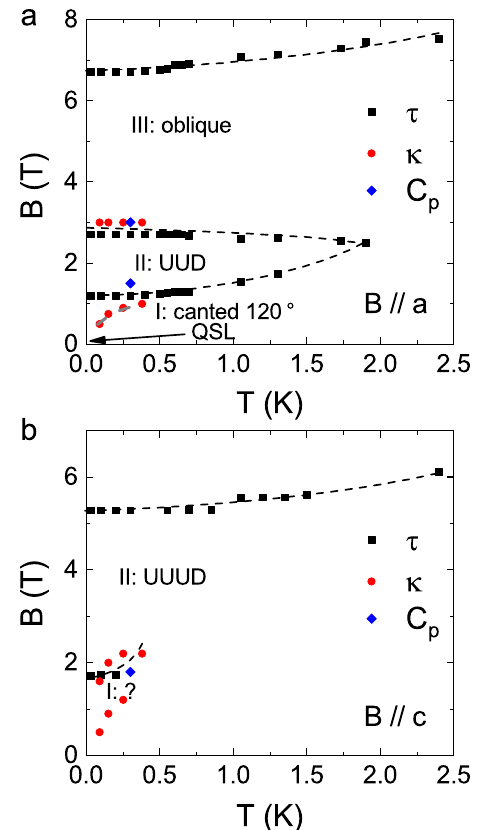
Fig. 5 Magnetic phase diagrams of YbMgGaO4. a For B // a . b For B // c . The data points are obtained from the magnetic torque ( τ ) and fi eld dependence of thermal conductivity ( κ ) measurements. The dashed lines are phase boundaries. For B // a , there are three phases (I: thee canted 120° spin structure, II: the UUD phase, and III: the oblique phase) in the low-temperature and low- fi eld region. Whereas, there are two phases (I: unknown phase and II: UUUD phase) at low temperature and low fi eld for B // c . The dashed lines are the guide to the